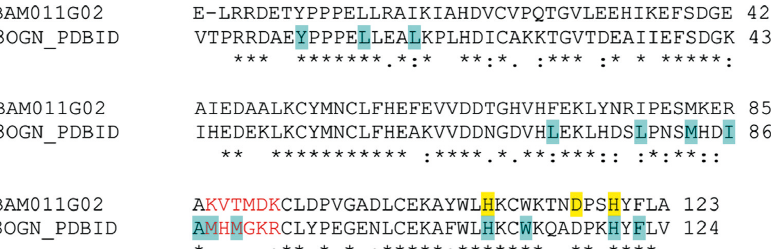
Figure 1: Global pairwise alignment of Lutzomyia longipalpis OBP sequence and the selected template sequence. ( ∗ ) Identity of amino acid residue aligned in the indicated column. (:) Similarity of amino acid residue aligned in the indicated column. (.) Low similarity of amino acid residue aligned in the indicated column. (-) Noncorrespondence (gap) site. Residues highlighted in blue are part of the template orthosteric site. Residues highlighted in yellow are the more ionizable residues from the C-terminal region. Red characters indicate poorly conserved region in the